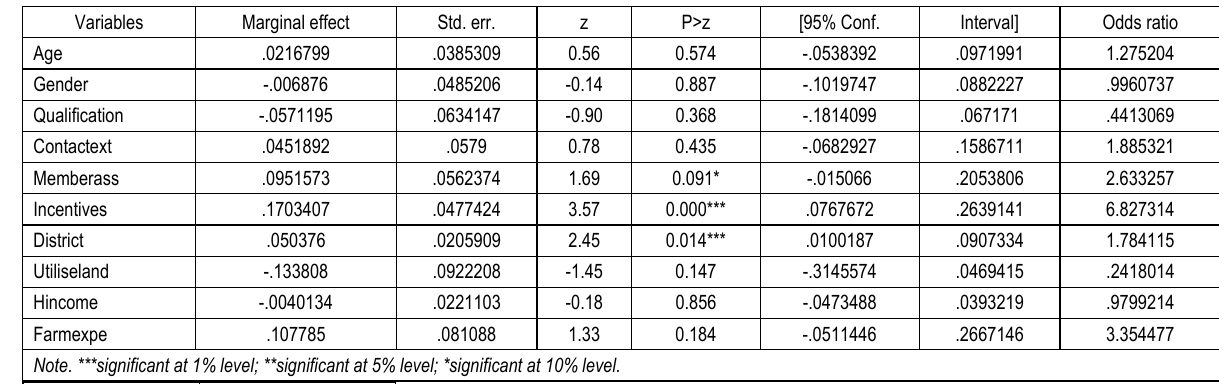
Table 3. Probit model